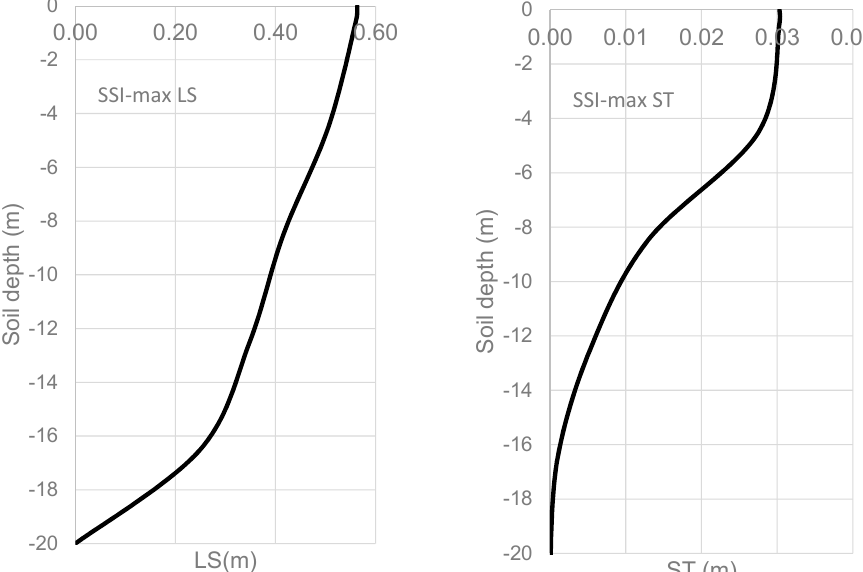
Figure 10. Soil–structure interaction (SSI): maximum lateral spread (LS) and settlement (ST) vs. soil depth (input motion 2, 100%).